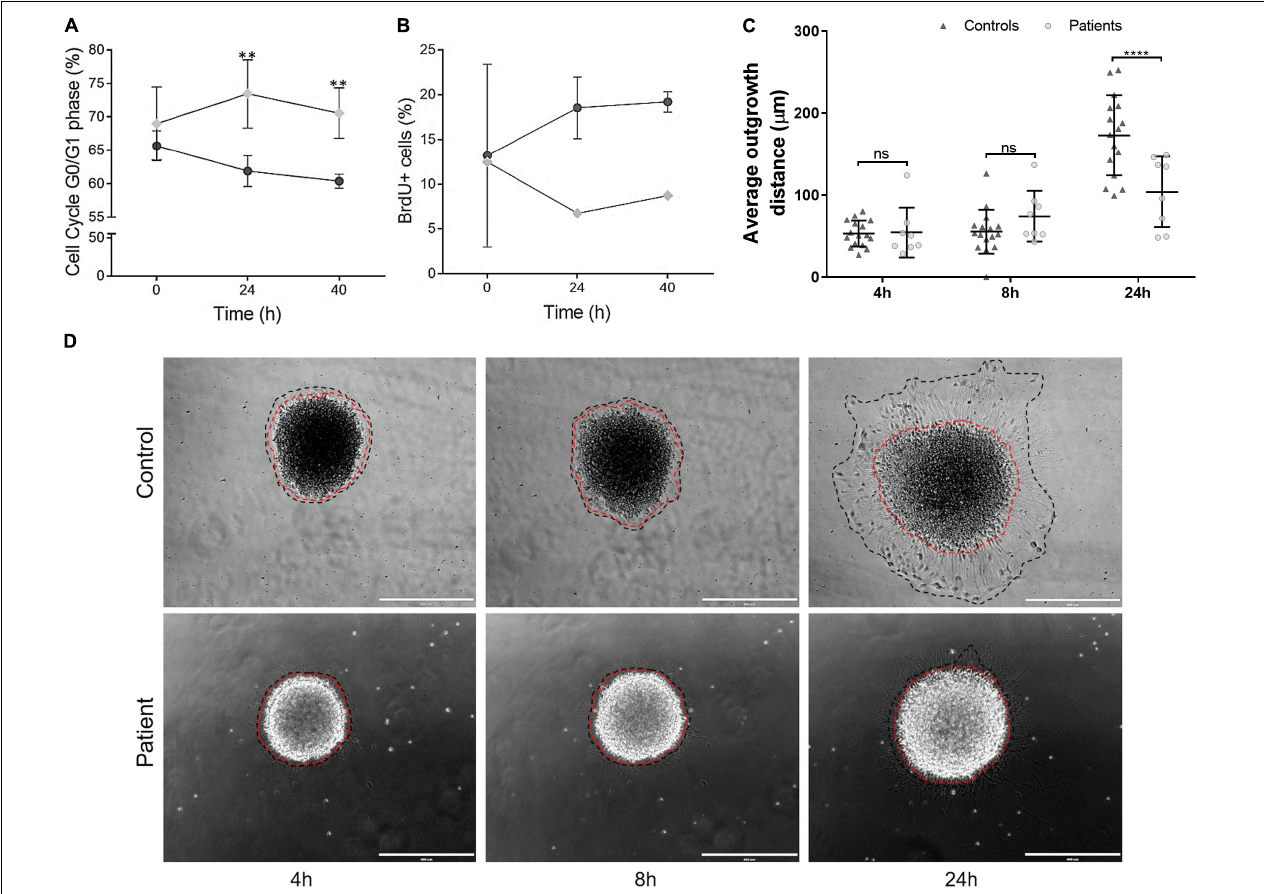
FIGURE 5 | iNPC expressing TBCK-mutated protein show altered cell cycle progression, cell proliferation, and cell migration. (A) G0/G1-phase analyses at three time points, showing an increased percentage of cells of patients arrested at G0/G1 cell cycle stage. Cell cycle experiments were replicated twice. (B) BrdU-positive cells showed that iNPC of patients had lower incorporation of BrdU. Data are shown as percentages. BrdU incorporation experiment was performed once for each sample. Patient: F6331-1; controls: F7007-1, F8799-1, and F10006-1. (C,D) iNPC migration from neurospheres, measured as the distance of the longest outer diameter of the cells that migrated from the neurosphere, normalized to the inner neurosphere edge. (D) Representative images of migration assay. Red dashed line—inner diameter; black dashed line—outer diameter. Scale bar = 400 µ m. Patients: F6331-1 and F6331-4 ( N = 2); controls: F7007-1, F8799-1, and F10006-1 ( N = 3); Neurosphere technical replicates = 4. Data are shown as mean values ± SD of patients and control biological replicates. ** p -value < 0.01, **** p -value < 0.0001, ns - not